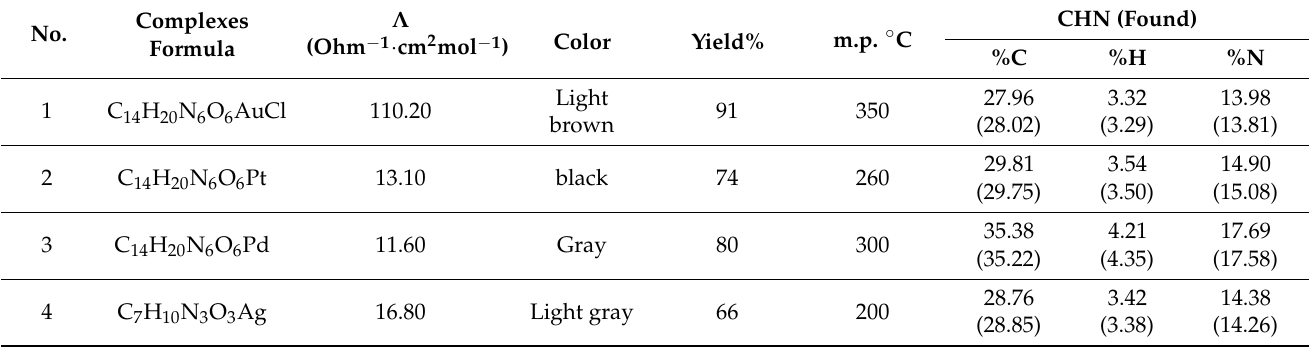
Table 1. Physical properties of secnidazole complexes.